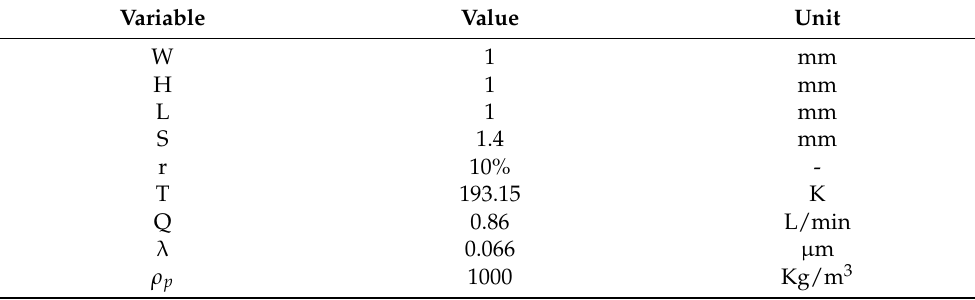
Table 2. Variables of the new low temperature virtual impactor design.